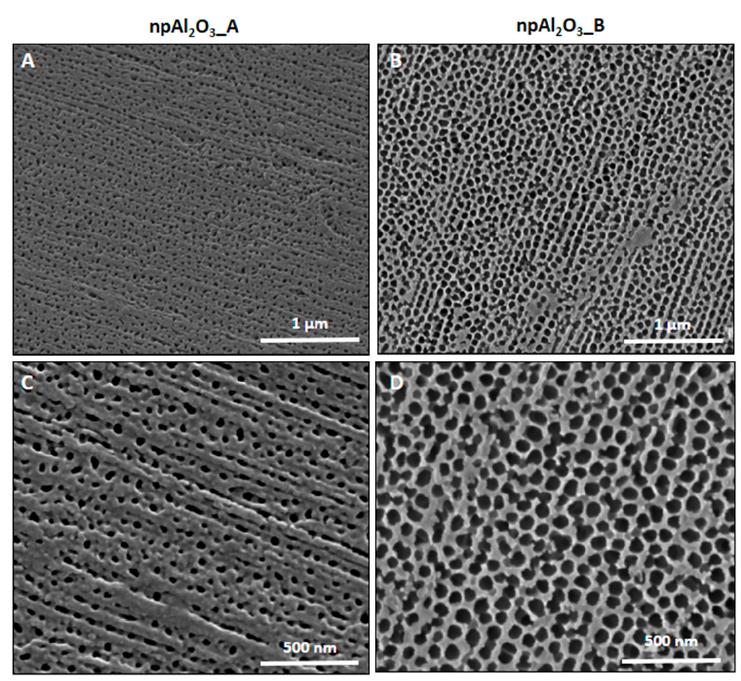
Figure 1. Electron microscopy. Field Emission Scanning Electron Microscope (FESEM) analysis of npAl 2 O 3 _A ( A , C ) and npAl 2 O 3 _B ( B , D ) at 100,000 ( A , B ) and 200,000 ( C , D ) magnifications.